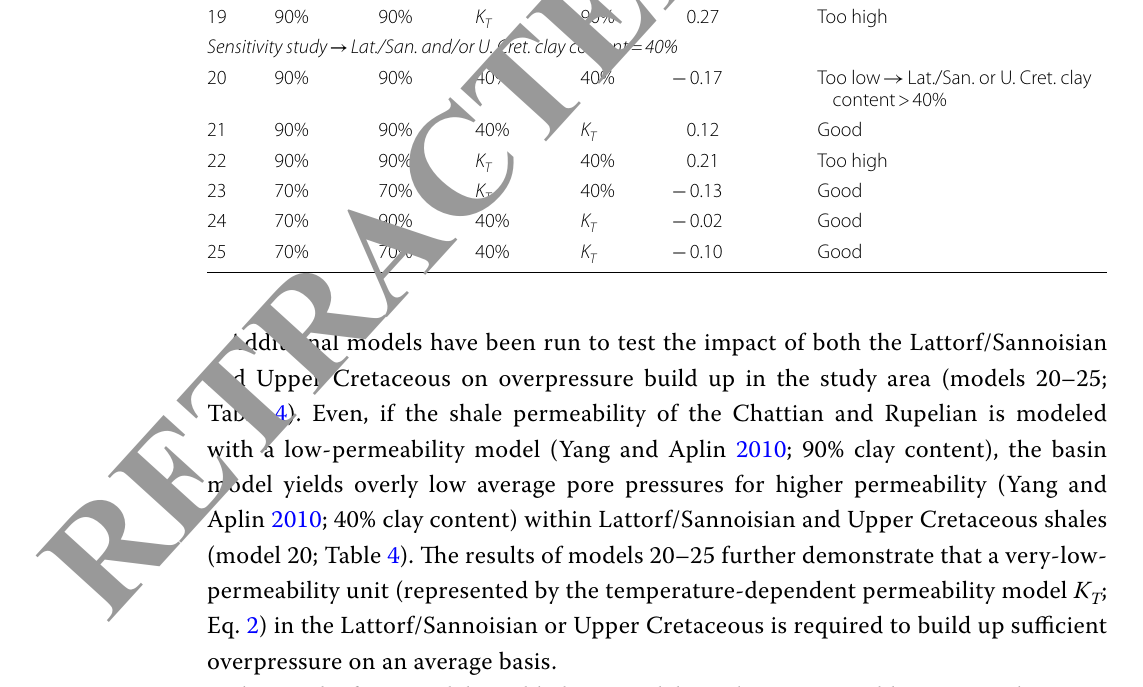
Decision: Chattian and Rupelian clay content